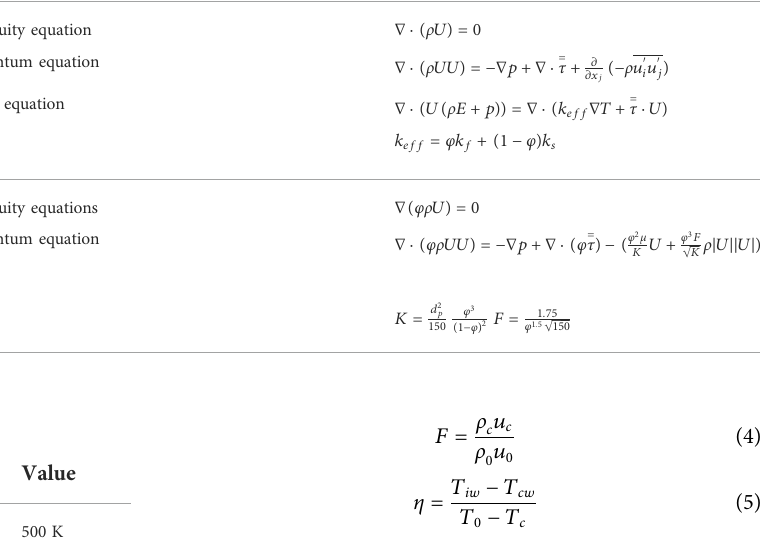
Where, ρ represents fl uid density, u represents fl ow rate, and T represents temperature. Subscript C represents coolant parameters and 0 represents mainstream parameters. T iw